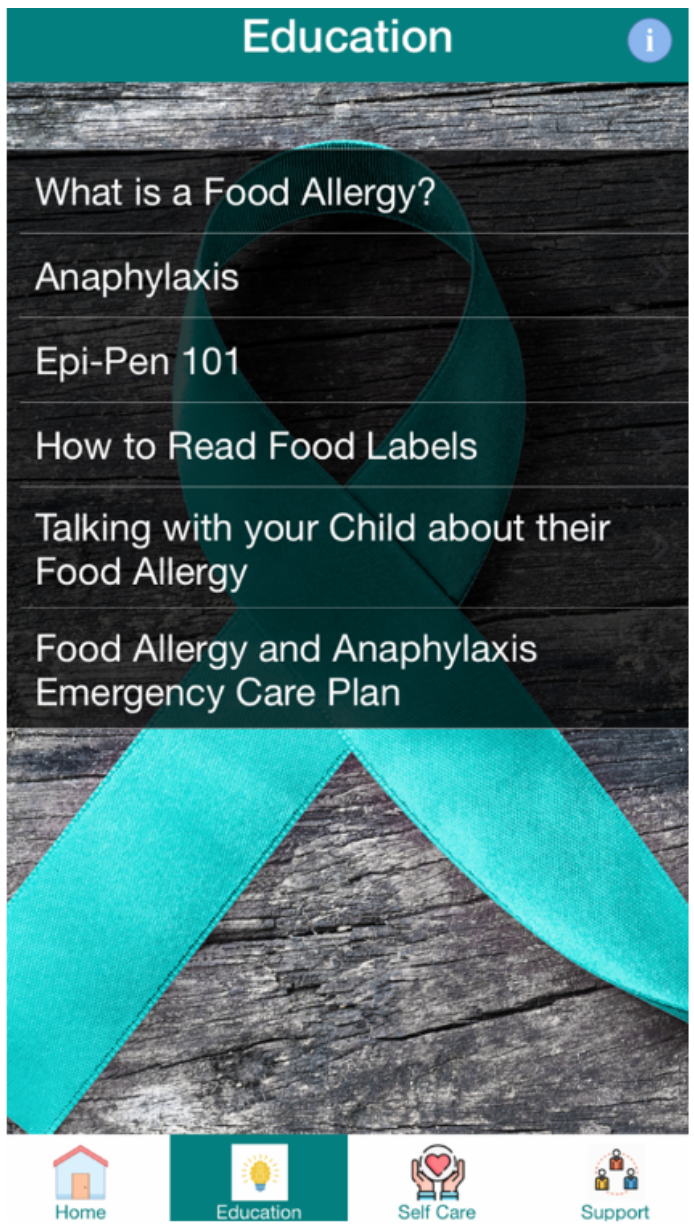
Figure 4. Sample Food Allergy Symptom Self-Management with Technology for Caregivers (FASST) mobile health (mHealth) smartphone app screen